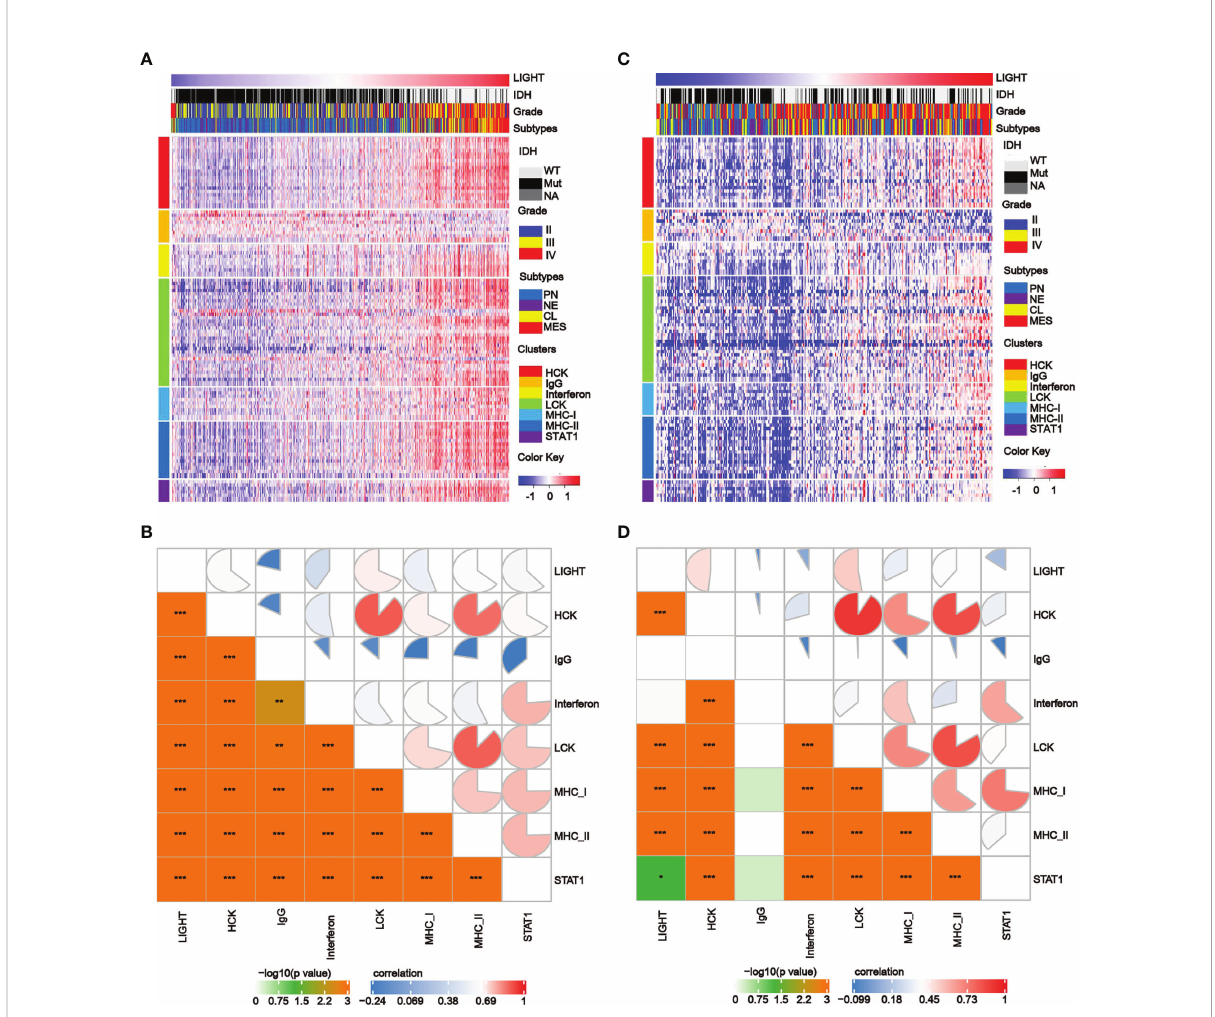
FIGURE 5 The correlation between LIGHT expression and T-cell immunity and immunity processes in all gliomas. (A, C) Heatmaps showing LIGHT-related immune activities of gliomas in the TCGA (A) and CGGA (C) datasets. The distribution of the LIGHThi and LIGHTlo groups, IDH status, WHO grade and molecular subtypes are displayed on the top of the heatmap, and the clusters of different immune activities are displayed on the left side. (B, D) Corrgrams illustrating the r values of Pearson correlation analysis between LIGHT and immunity metagenes in TCGA (B) and CGGA (D)